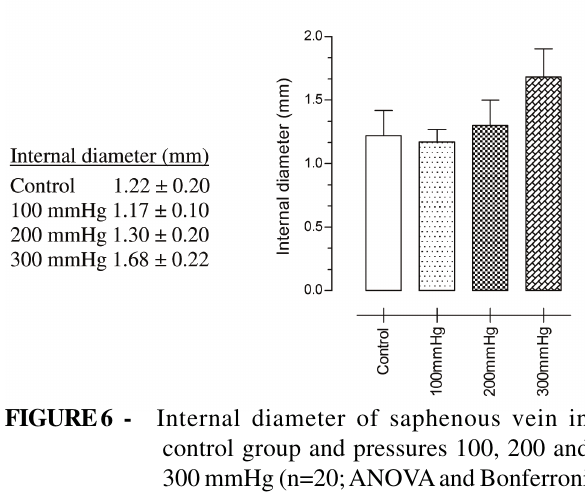
FIGURE 6 - Internal diameter of saphenous vein in control group and pressures 100, 200 and 300 mmHg (n=20; ANOVA and Bonferroni post test, p >